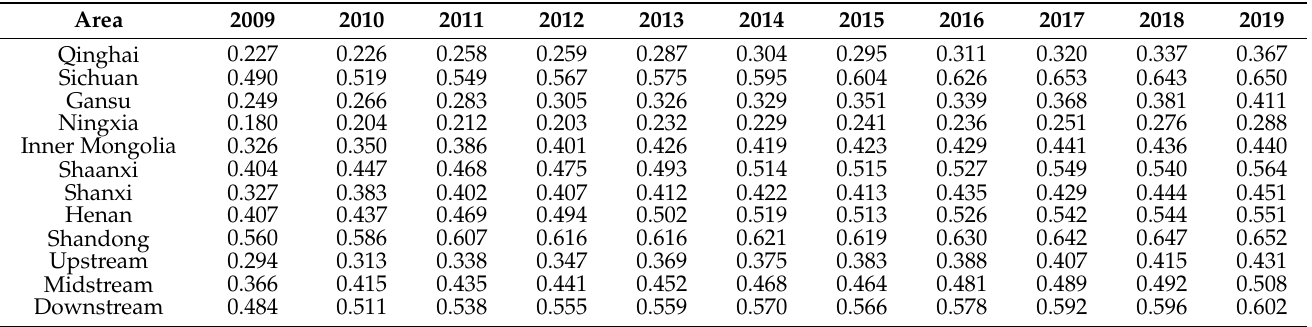
Table 5. Coordinated development index of provinces and upstream, midstream, and downstream of the Yellow River Basin from 2009 to 2019.